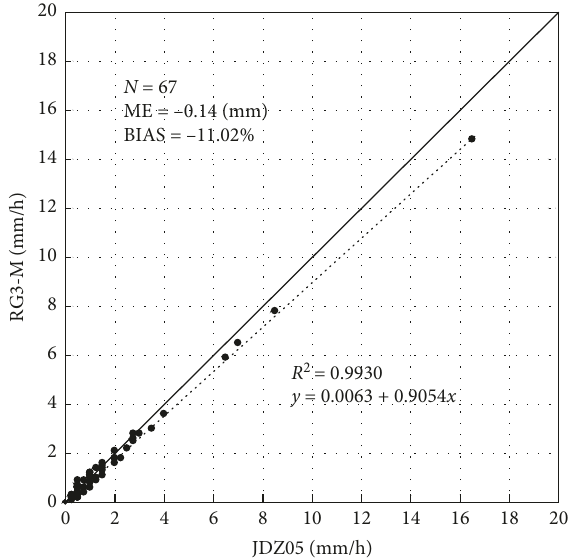
Figure 6: Comparison of average hourly rainfall of the RG3-M gauge and the JDZ05 gauge at the hydrometeorological observation